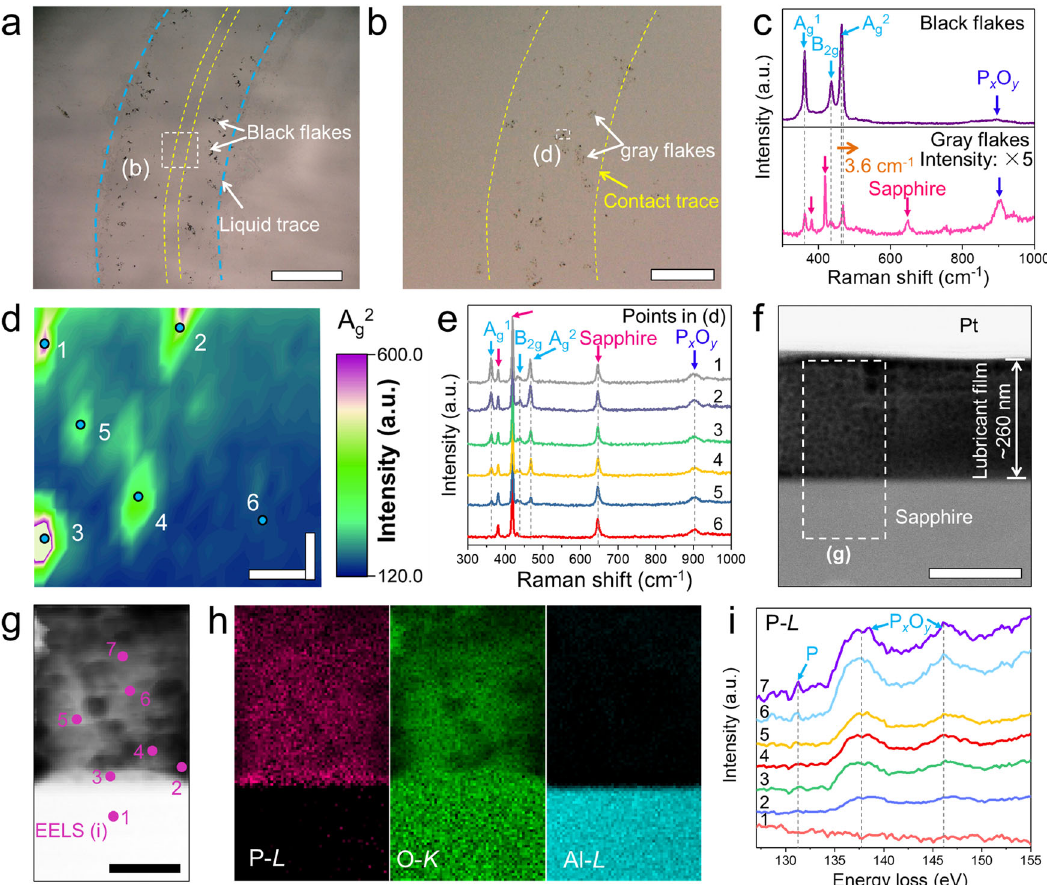
Fig. 5 Characterization of the wear trace on the sapphire disc surface after the friction test with the oBP nanosheets suspension (test condition: 2 N and 100 mm/s). a Optical image showing the residual liquid traces after the friction test. Scale bar: 500 μ m. b Optical image showing the actual contact trace with the wear scar on the Si 3 N 4 ball as marked in a . Scale bar: 50 μ m. c Raman spectra of the black and gray fl akes as marked in a , b . d Raman A g2 intensity map of the region as marked in b . Scale bar: 2 μ m. e Raman spectra of the region as marked in d . f , g HAADF-STEM images showing the existence of a porous lubricant fi lm on the top of the sapphire disc surface. Scale bar: 200 nm in f and 100 nm in g . The position for the EELS spectrum image mapping and the acquisition points are also indicated. h EELS P- L , O- K , and Al- L maps showing the elemental distributions in the region as marked in f , g . i Evolutions of EELS P- L core edge spectra recorded at the points as marked in g